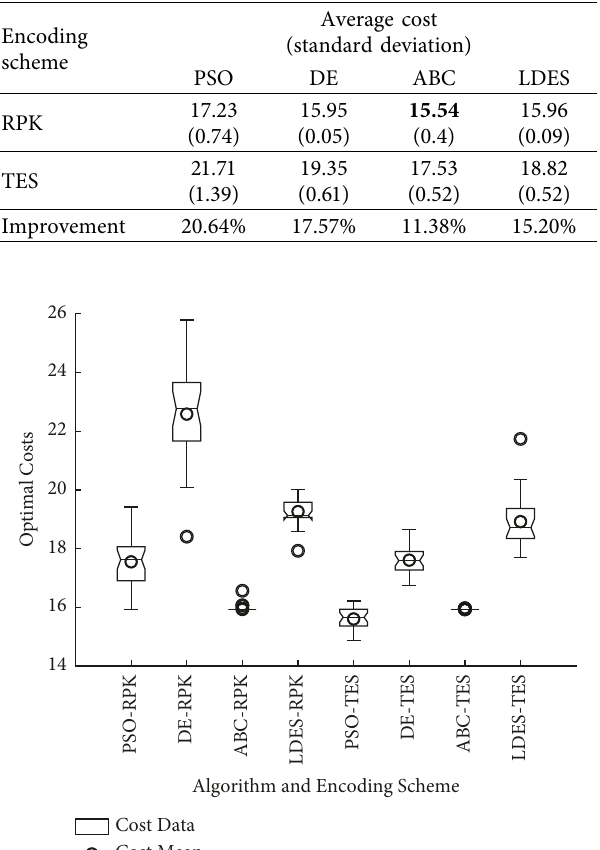
Figure 5: Location and demands of delivery points. The circles show the location, and the circle’s diameter shows the value of demand. The larger the diameter, the greater the demand. Table 3: Average cost over 30 runs and standard deviate for PSO, DE, ABC, and LDES using RPK and TES encoding scheme.